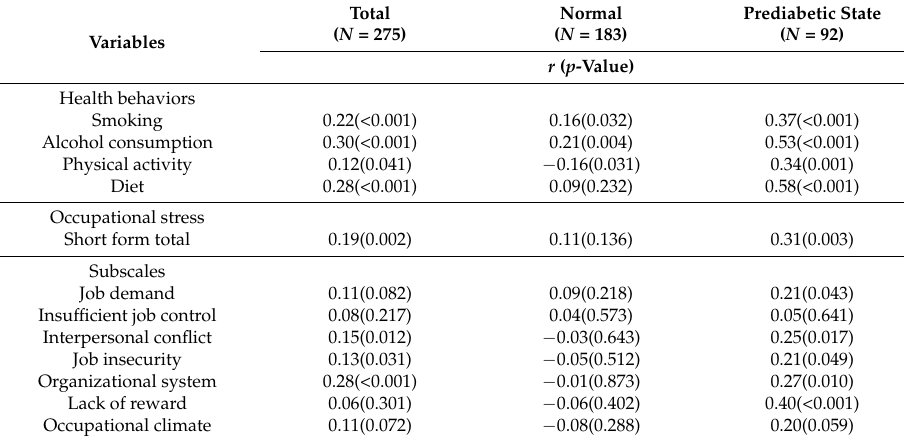
Table 2. Correlation of Health Behaviors and Occupational